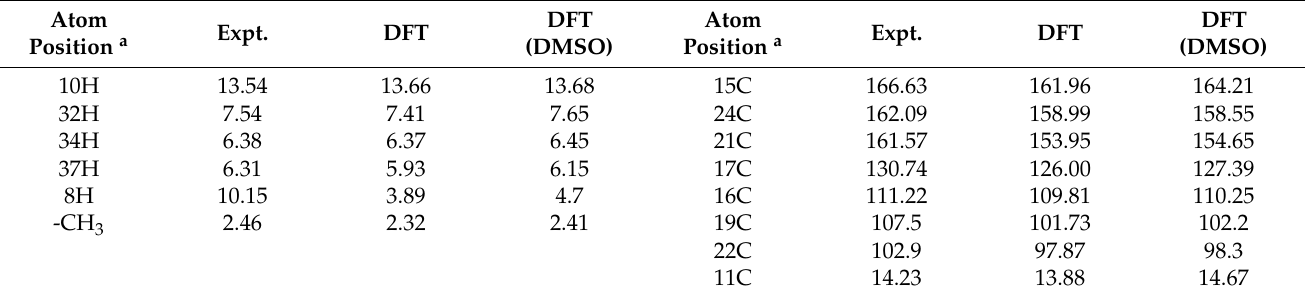
a Refer to Figure 4 for the atom positions; Expt., experimental; DFT, density function theory; DMSO, dimethyl sulfoxide.